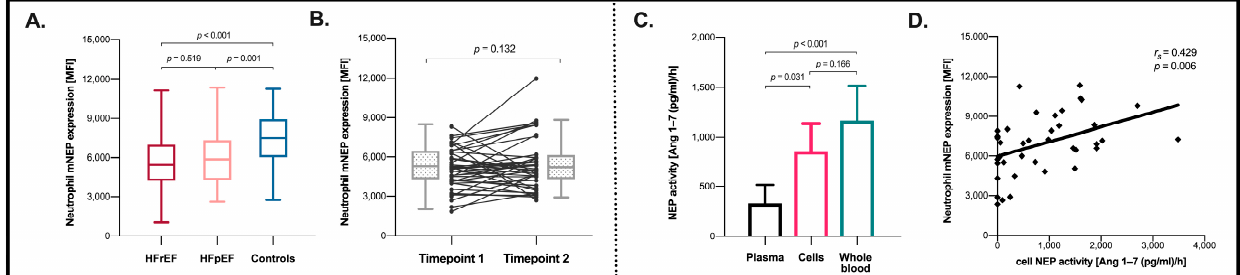
Figure 1. ( A ) Neutrophil membrane-associated neprilysin (mNEP) expression in HFrEF, HFpEF and controls. ( B ) Timely variance of neutrophil mNEP expression. ( C ) Mass spectrometry-based determination of the enzymatic activity of NEP in whole blood, peripheral cells, and plasma (n = 40). ( D ) Scatter plot with linear regression analysis and the Spearman rho correlation coefficient for neutrophil mNEP expression with peripheral cell mNEP activity. Comparison between groups was assessed by using the Kruskal–Wallis test, Mann–Whitney test, and paired Wilcoxon test. Levels of significance are indicated in the respective plots. Tukey boxplots are shown in ( A , B ); ( C ) displays geometric means and 95% confidence